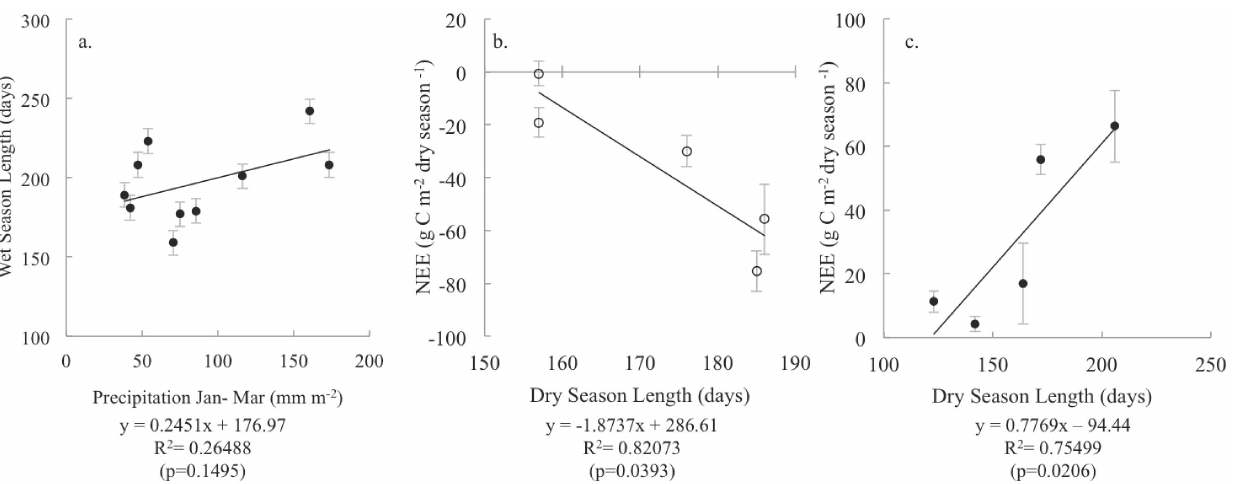
Fig. 4. Precipitation, season length, and CO 2 Exchange rates. (a) The relationship between cumulative precipitation (January through March) and wet season length at TS and SRS shows that precipitation prior to the wet season is an important determinant of wet season length. The relationship between dry season length and dry season NEE is positive at (b) TS and negative at (c)